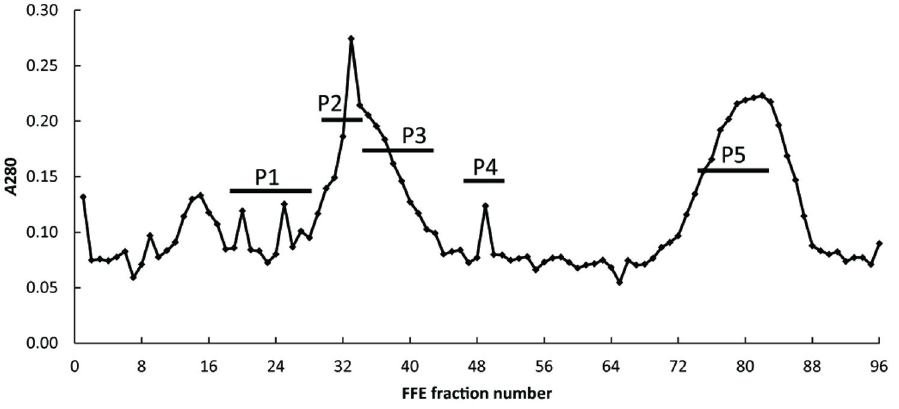
Figure 1. Post-FFE protein profile of enriched Golgi membrane preparations from strong compression wood (sCW) of developing pine xylem. FFE separated samples are distributed into 96-wellplates and protein distribution can be monitored by absorbance (A nm). The post-FFE profile for both the mCW and sCW samples derived from the 0.75/1.0 M interface had similar 280 profiles. The FFE fractions were pooled as follows: P1; fractions 16 to 30, P2; fractions 31 to 33, P3; fractions 34 to 40, P4; fractions 48 to 50 and P5; fractions 72 to 80. CW-P1 to P5 were concentrated and analyzed for GalS activity (Table S5 in File S1). doi: